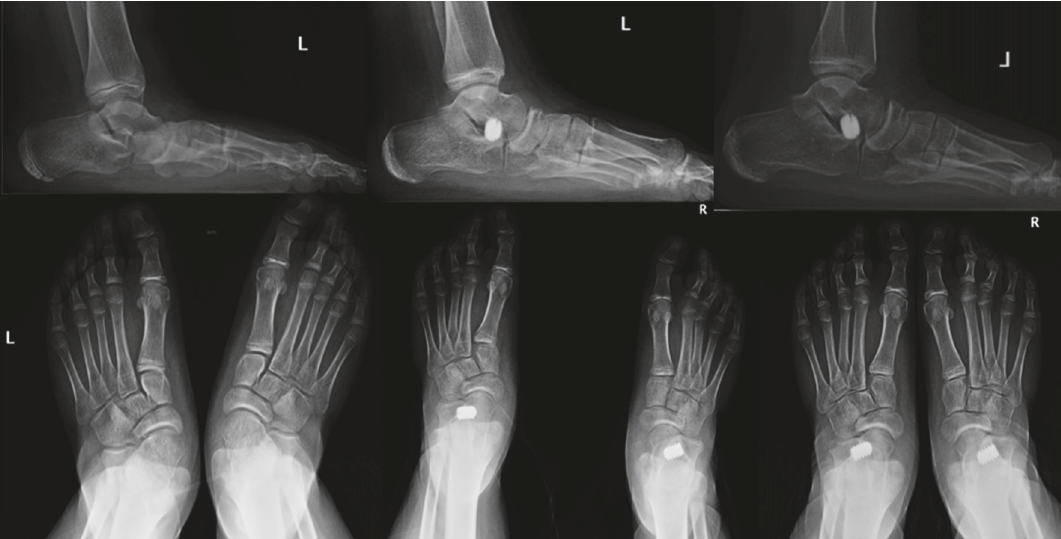
Figure 2: Male patient aged 11 years with bilateral flatfoot, showing foot remodeling trends after subtalar implant. The images in the centre were taken two months after operation; the images on the right correspond to two years after